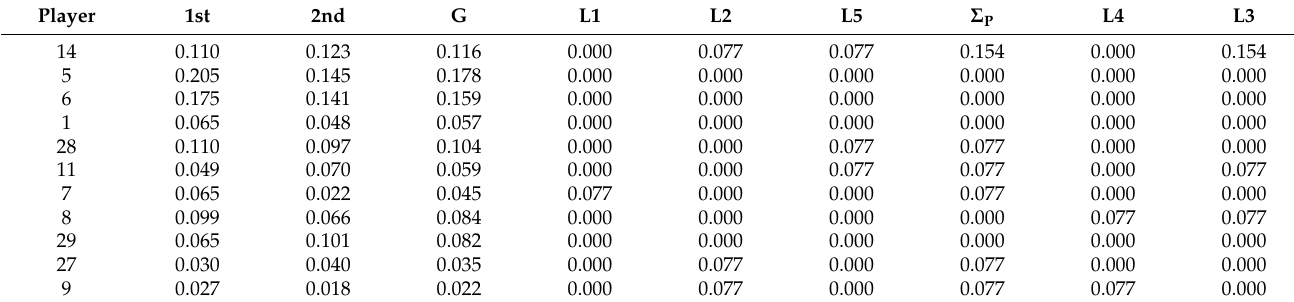
Table A2. Team B’s Degree Centrality Matrix of values.